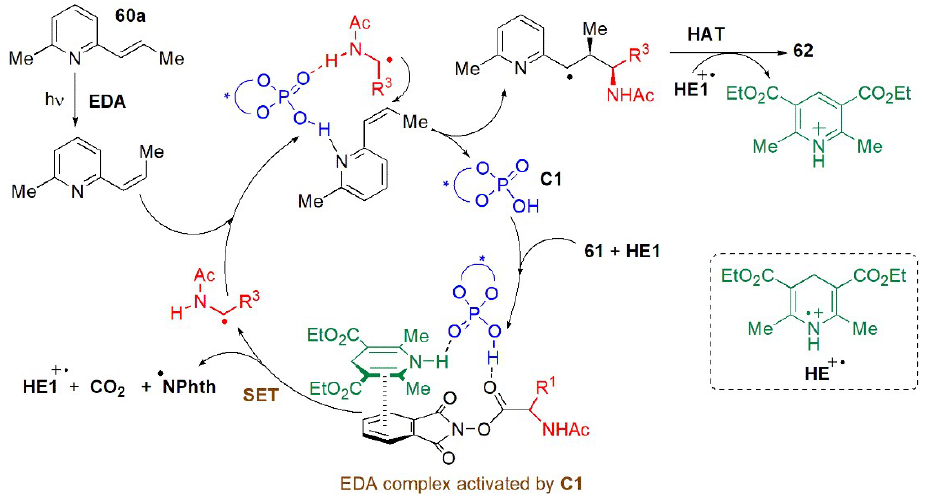
Figure 23. Mechanism proposed for the enantioselective hydroalkylation of internal alkenylpyri- dines [93].